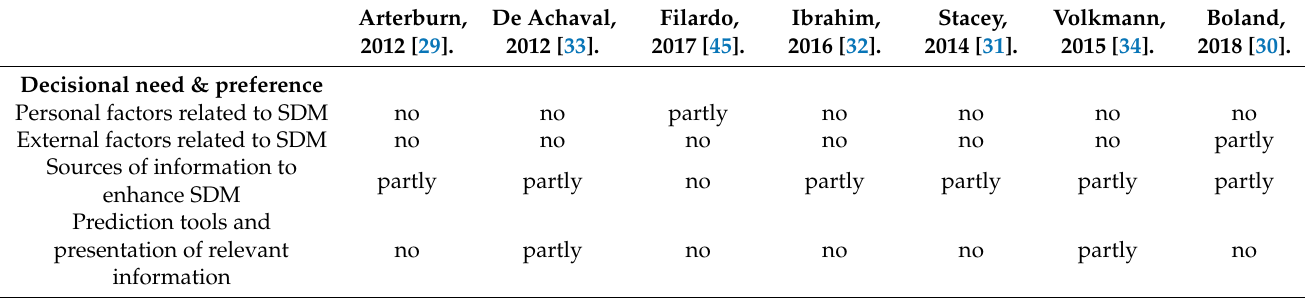
Table A6. Synthesis of the relationship between included studies in RQ2 and the needs & preferences, found in